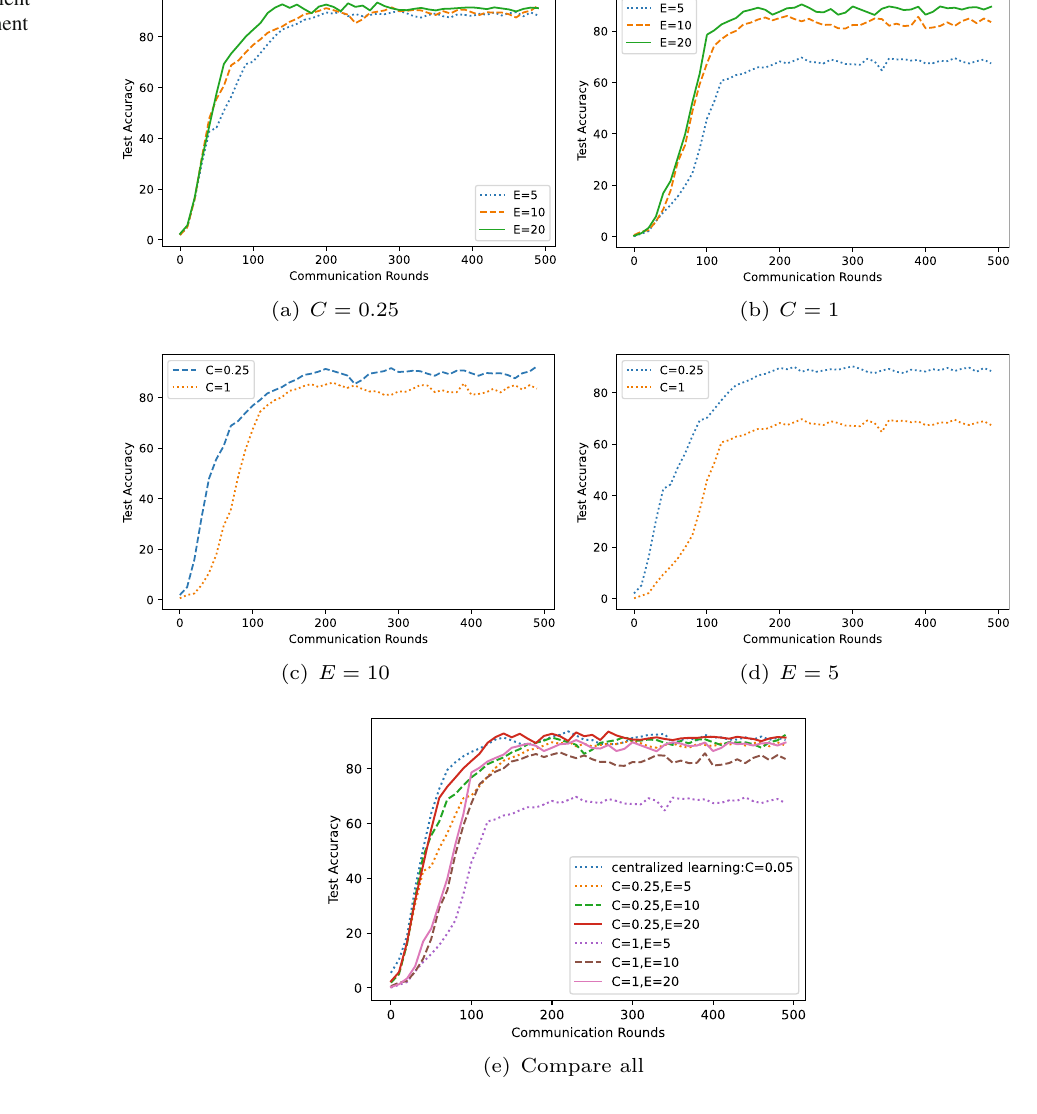
Fig. 5 The influence of client parameters on the experiment